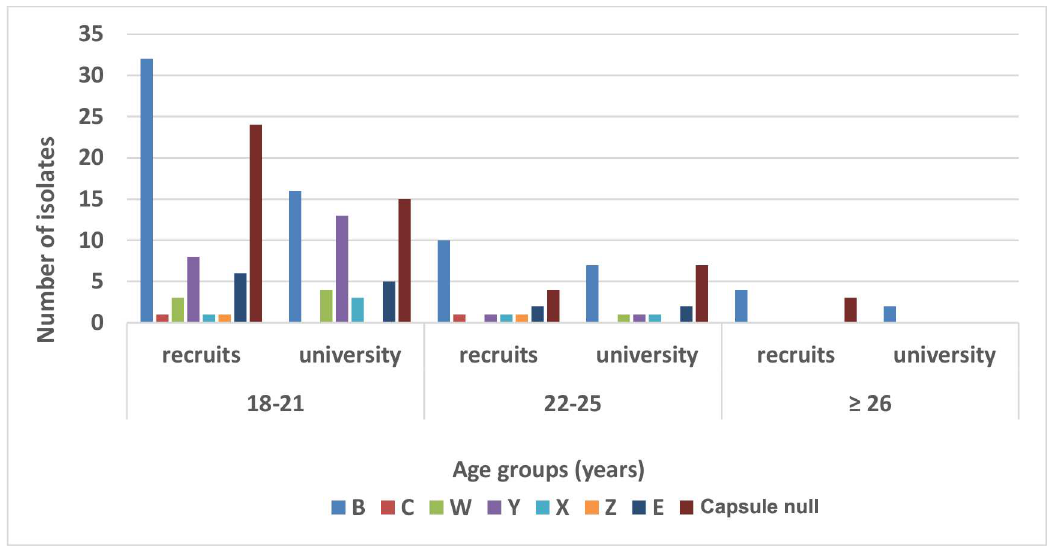
Fig 1. Genogroup distribution by age and examined group